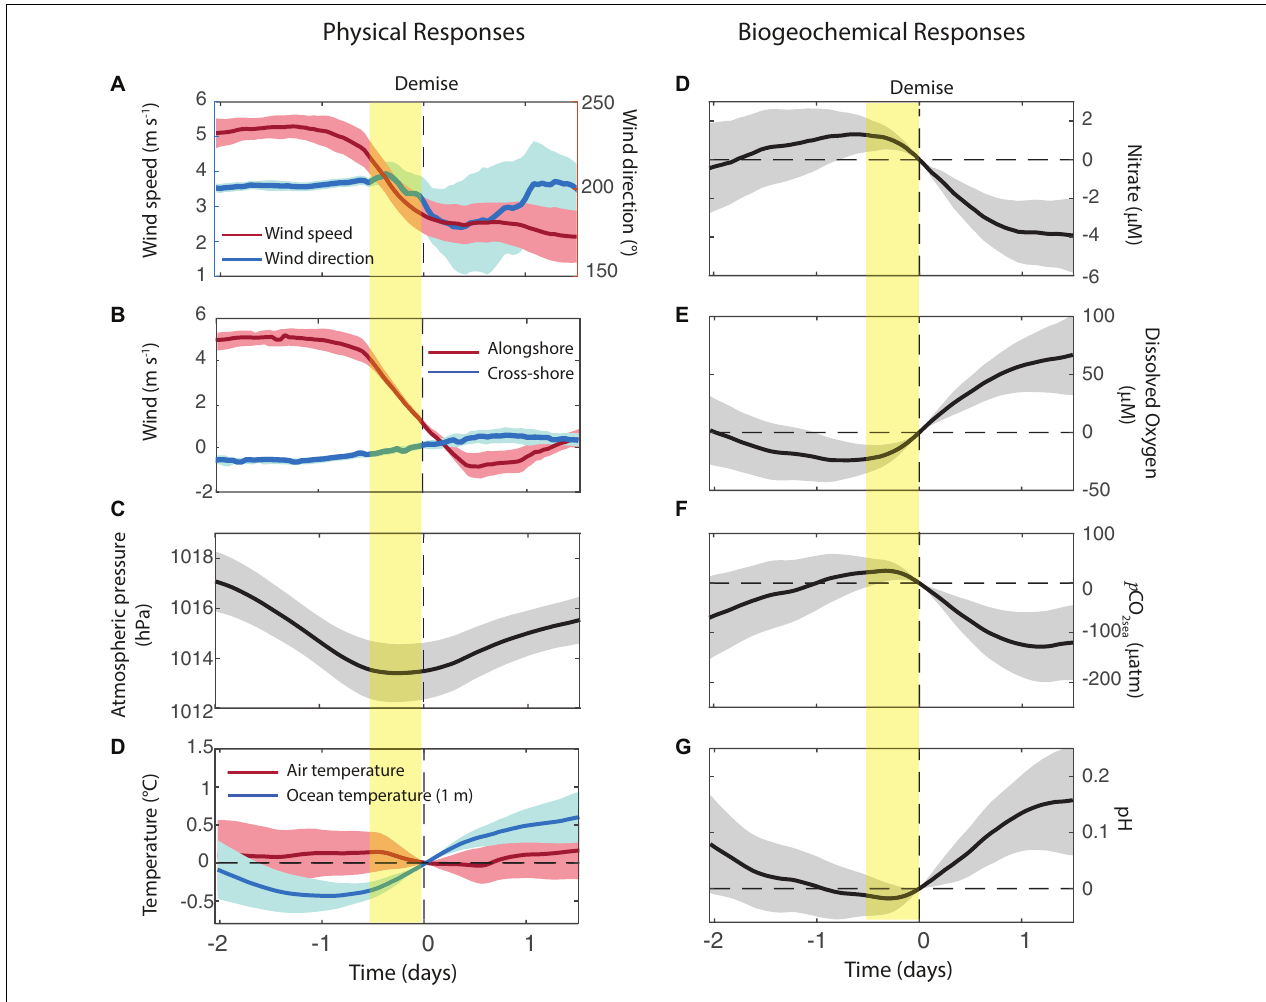
FIGURE 8 | Composite analysis of selected variables during the demise of the upwelling events. (A) Wind speed and direction, (B) Alongshore wind (red line) and cross-shore wind (blue line), (C) Sea level atmospheric pressure, (D) Air temperature (red line) and ocean temperature at 1 m depth (blue line), (E) Nitrate, (F) Dissolved Oxygen, (G) p CO 2 sea , and (H) pH. Vertical yellow bars indicate 12 h before the demise of the upwelling